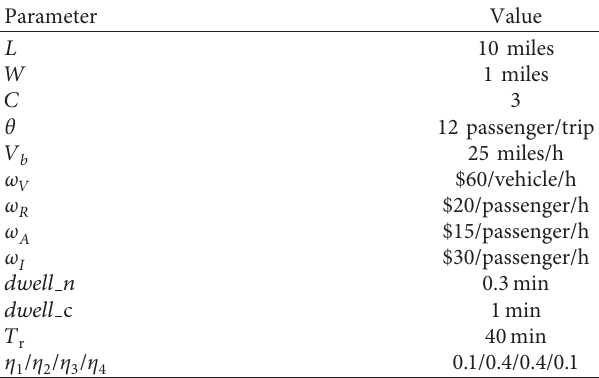
Table 1: Parameter